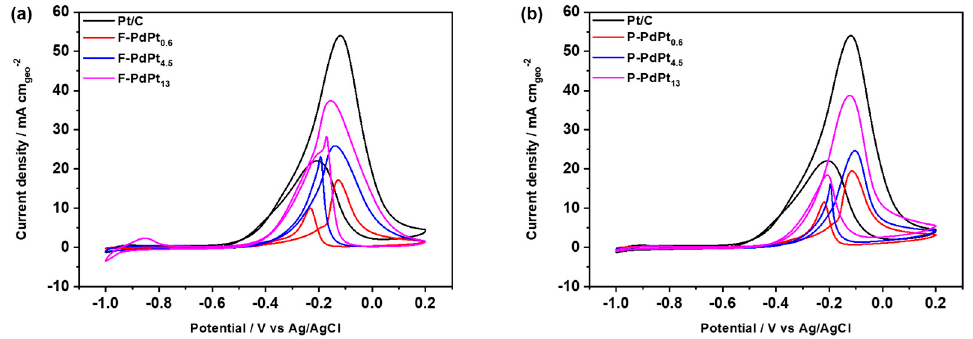
Figure 5. Cyclic voltammetry curves of ( a ) F-PdPt and ( b ) P-PdPt core–shell nanocubes with different Pt content in aqueous CH 3 OH (1 M) + KOH (1 M). Scan rate was 50 mV s − 1 .